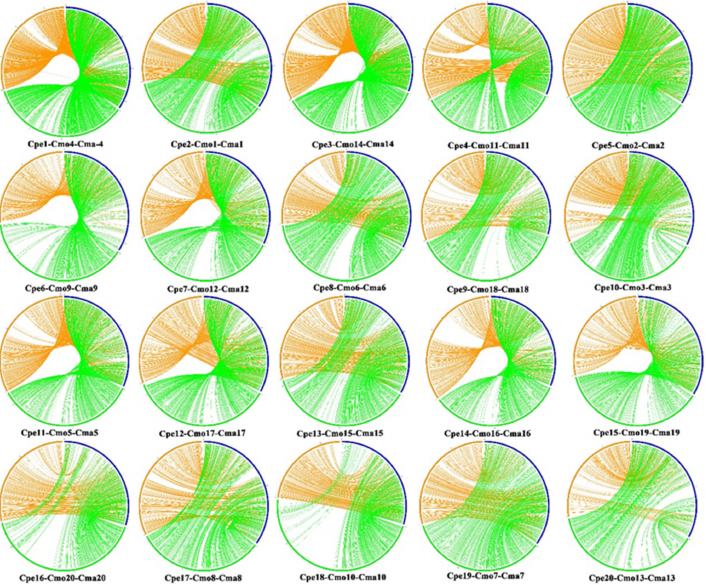
Figure 4. Chromosome synteny of C. pepo (blue) with C. moschata (green) and C. maxima (yellow). The physical positions of chromosomes of each crop in the figure are arranged clockwise. Chromosome synteny between C. pepo and C. moschata was based on 14,276 cross-species markers; synteny between C. pepo and C. maxima was based on 10,655 cross-species markers. Cpe1–Cpe20 represent C. pepo ’s twenty chromosomes, Cmo1–Cmo20 represent C. moschata ’s chromosomes, and Cma1–Cma20 rep- resent C. maxima chromosomes. The syntenic relationship between C. pepo and C. moschata are connected with the green color lines, and the syntenic relationship between C. pepo and C. maxima are connected with the yellow color